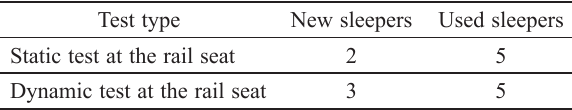
Table 2. Programme of experimental research Test type